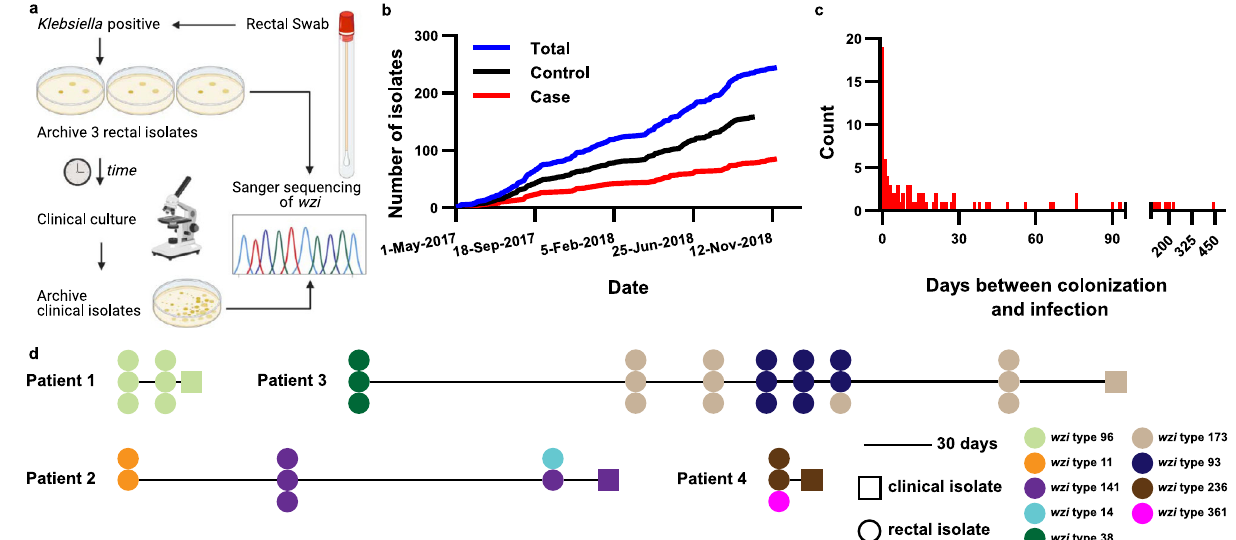
Fig.1|Descriptionof Klebsiella isolatecollection.a Schematicrepresentationof Klebsiella isolate collection and wzi -based concordance testing for WGS selection. b Rectal isolate selected for WGS collection dates strati fi ed by case status.